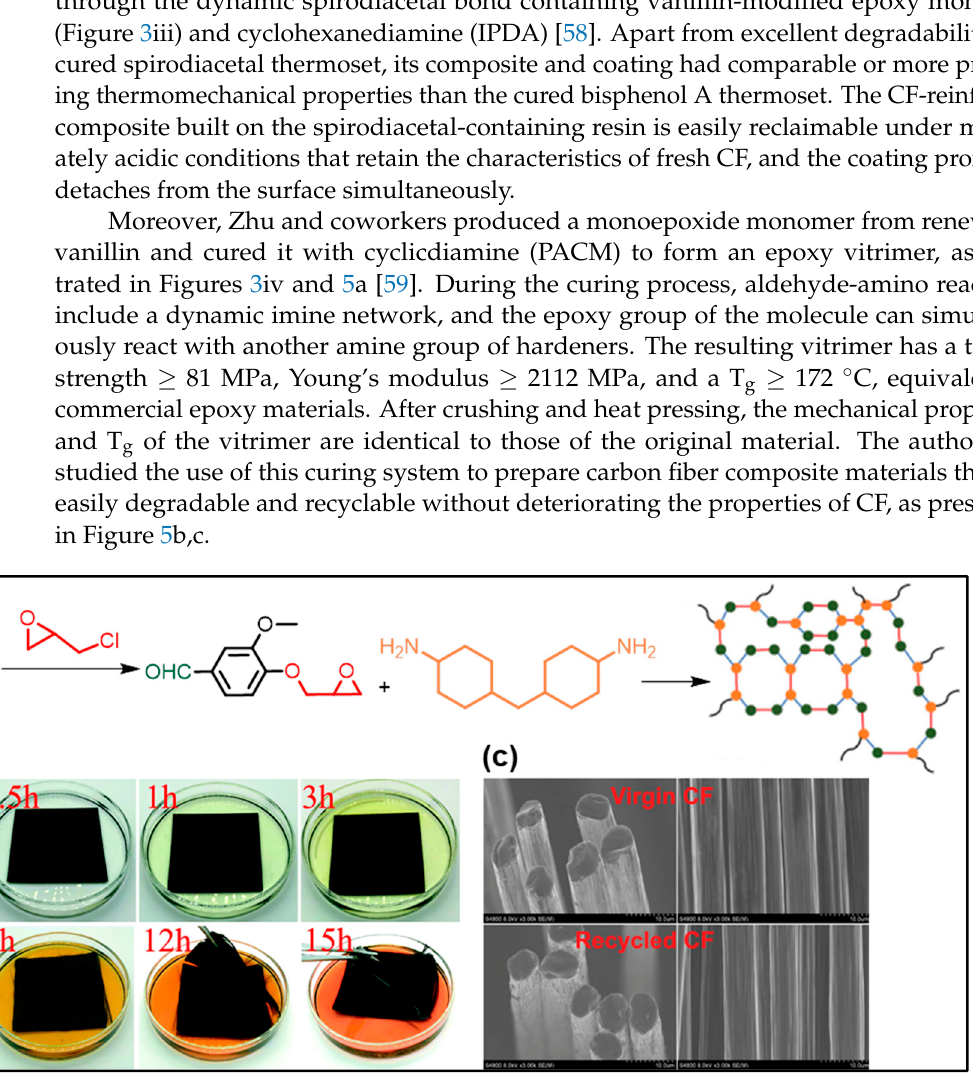
Figure 5. ( a ) Preparation way of epoxy vitrimer, ( b ) epoxy thermoset decomposition in 0.1 M HCl solution (methanol/H 2 O = 8/2, V/V) at normal temperature for the recovery of carbon fibers from CFRCs, and its SEM images ( c ) [reproduced with permission from Wang et al.; published by RSC, 2019] [59].